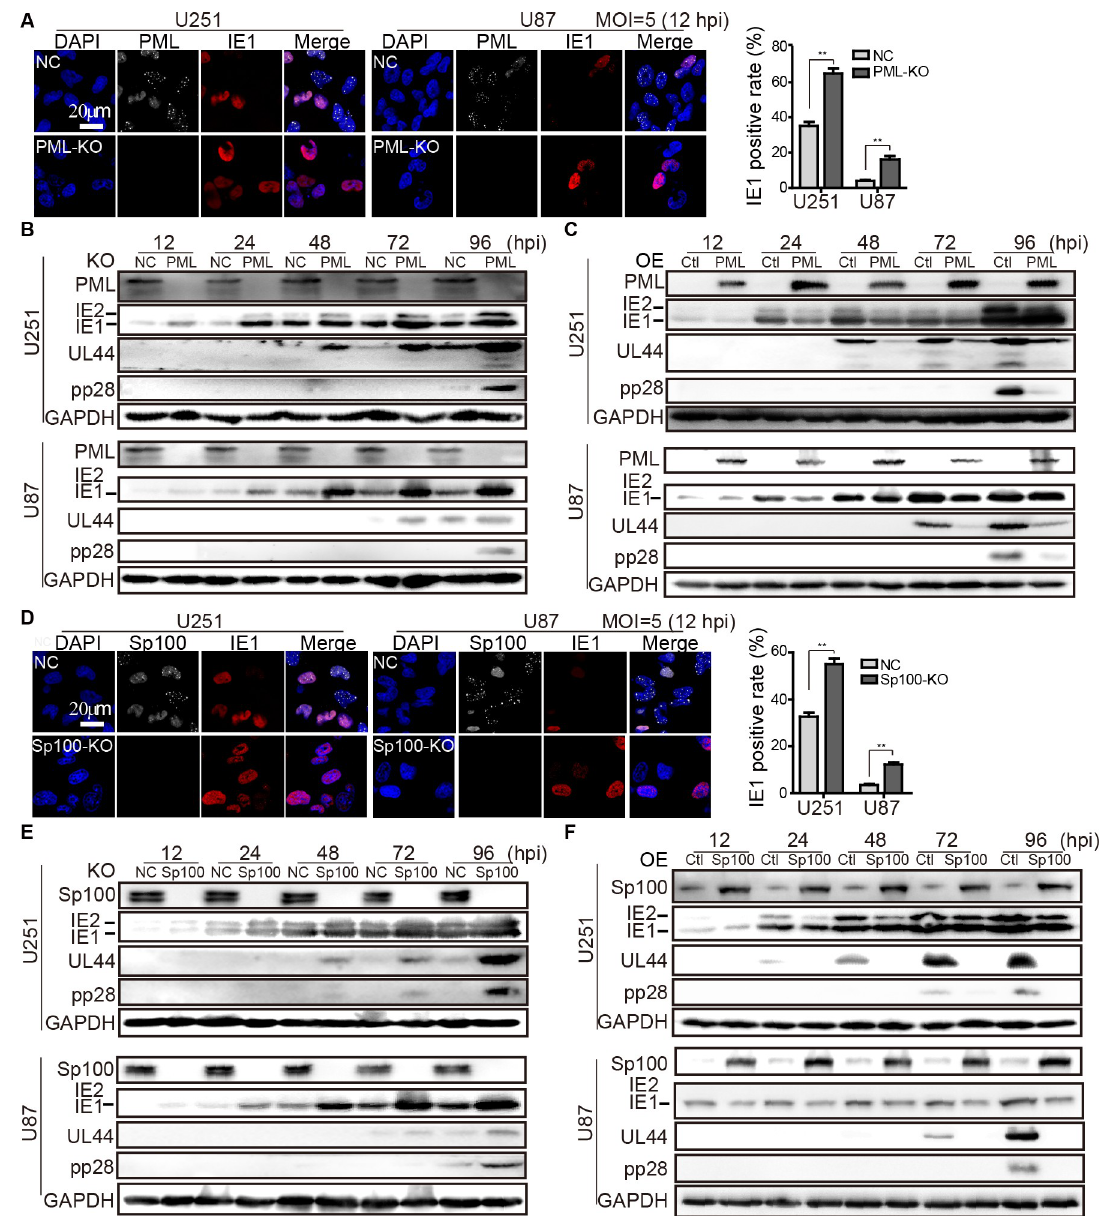
Fig 4. Both PML and Sp100 suppress HCMV gene expression in glioma cells. PML-KO, PML-OE, Sp100-KO, Sp100-OE, and their corresponding control cells were made with lentiviral transduction in U251 and U87 cells. These cells were infected with HCMV strain Towne at an MOI of 5 and harvested or fixed at the indicated times for viral gene expression determination. ( A ) Effect of PML-KO on HCMV IE1 expression by IFA. Representative images from three independent experiments are shown. Viral protein levels in PML-KO and NC ( B ), as well as PML-OE and Ctl cells ( C ), were examined by IB. ( D ) Effect of Sp100 on HCMV IE1 expression by IFA. IE1 positive cells in Sp100-KO and NC of U251 and U87 were quantified. Viral protein levels in Sp100-KO and NC ( E ), as well as Sp100-OE and Ctl cells ( F ), were examined by IB. GAPDH serves a loading control. For ( A ) and ( D ), IE1 positive cells were counted and normalized to the total cell number to calculate IE1 positive rates. Five random fields per coverslip from three coverslips were quantified in each independent experiment. Data collected from three independent experiments are shown as means ± SEM (Student’s t-test; ns, not significant; ** , p < 0.01).